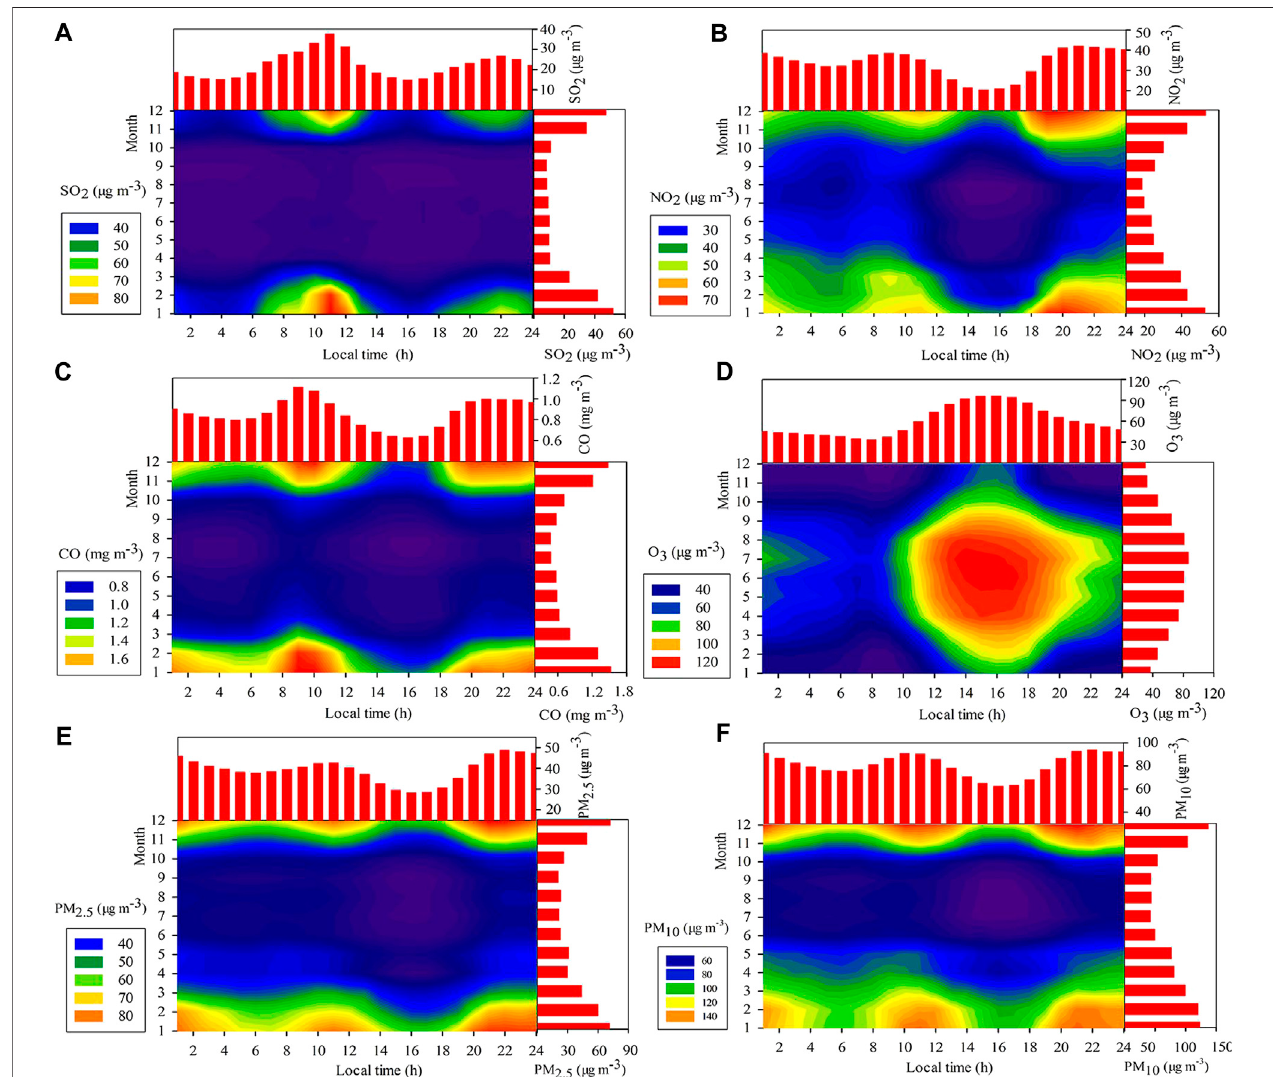
FIGURE 3 | Concentrations of gaseous and particulate matter in Tianshui at various daily and yearly times. (A) SO 2 . (B) NO 2 . (C) CO. (D) O 3 . (E) PM 2.5 . (F) PM 10 .